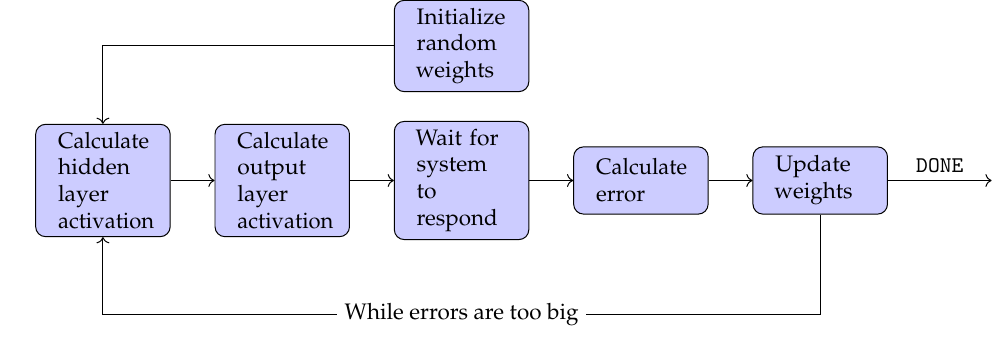
Figure 9. Flowchart illustrating the back-propagation algorithm.